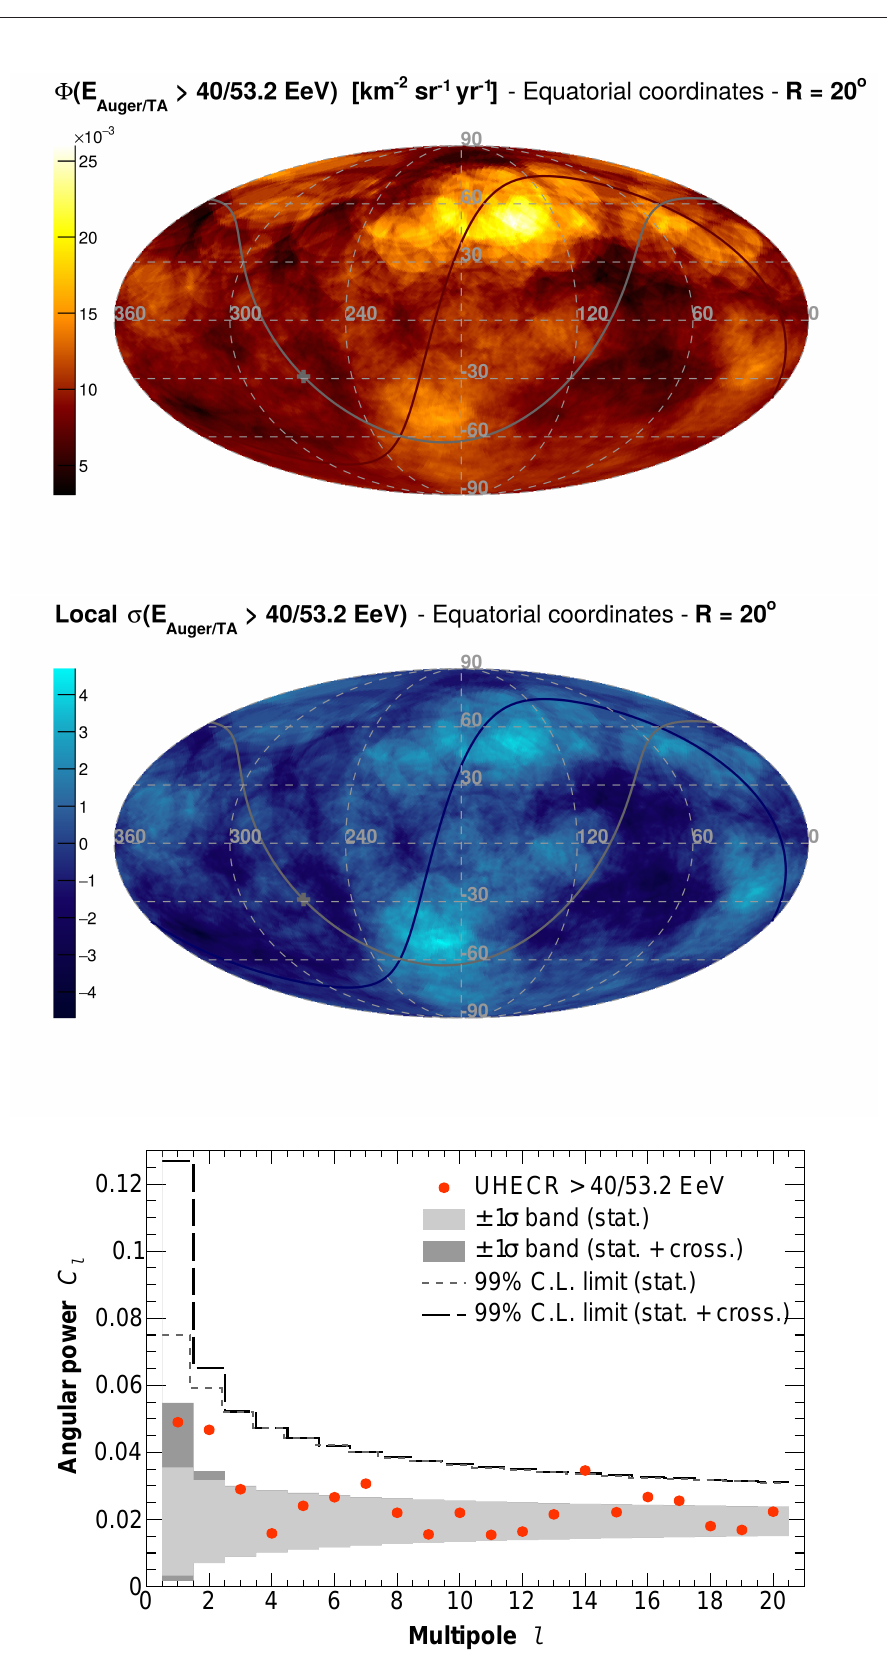
Figure 4. Flux ( Top ) and significance ( Mid-panel ) maps reconstructed at E Auger / TA > 40 / 53 . 2EeV. The gray line indicates the Galactic plane and the dark line the supergalactic plane. Bottom: Angular power spectrum at E Auger / TA > 40 / 53 . 2EeV. See caption in Fig. 3 for more